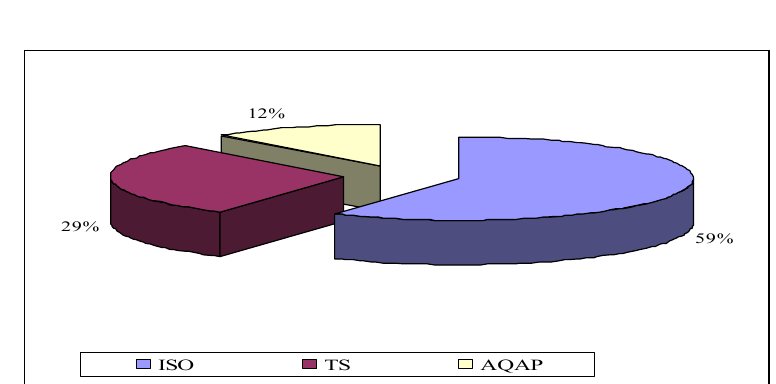
Figure 2 - Structure of organisations according to